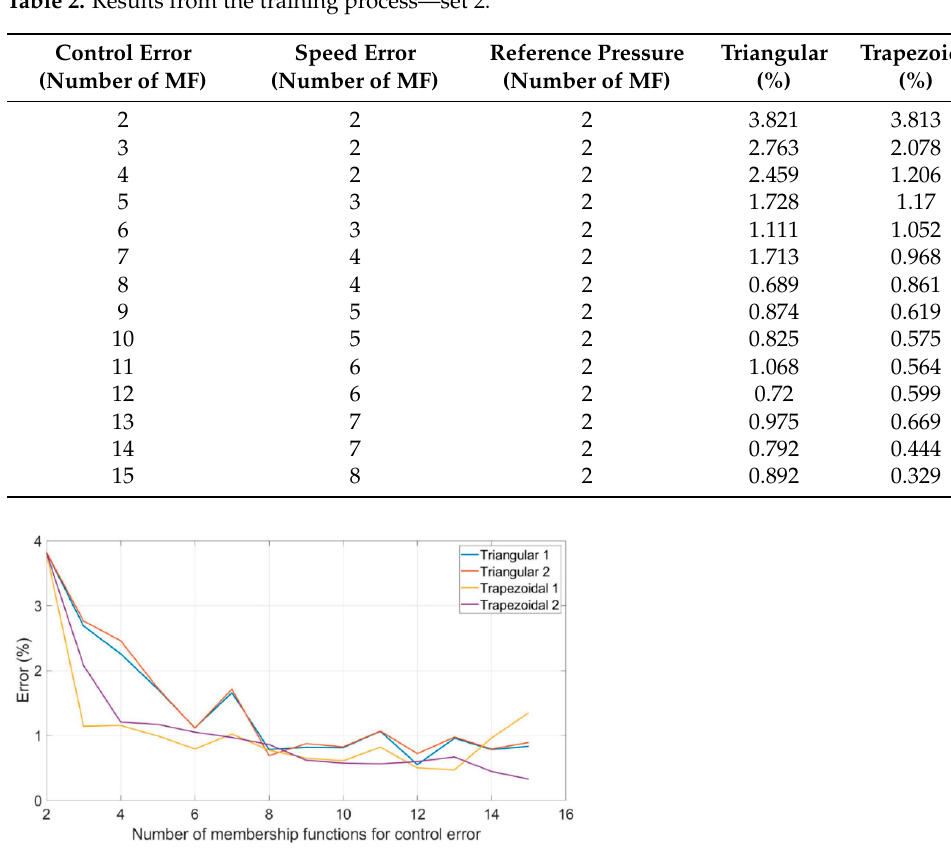
Figure 9. The results of the training process for different numbers of membership functions.